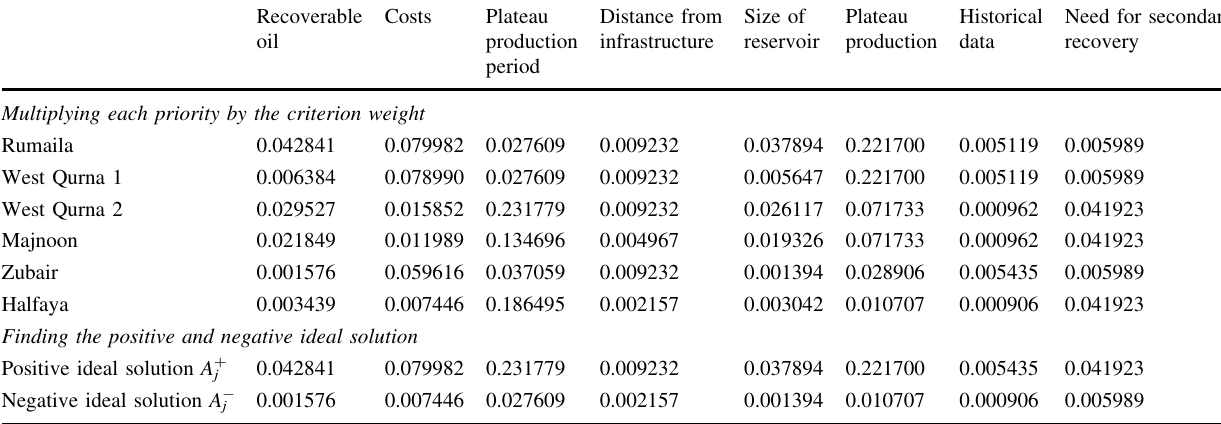
Table 12 TOPSIS—weighted normalized matrix and ideal solution